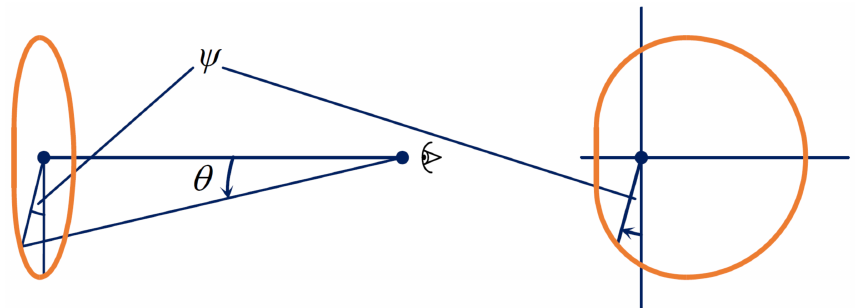
Figure 12. Celestial angles in the observer’s sky, for more details see Figure 8 in